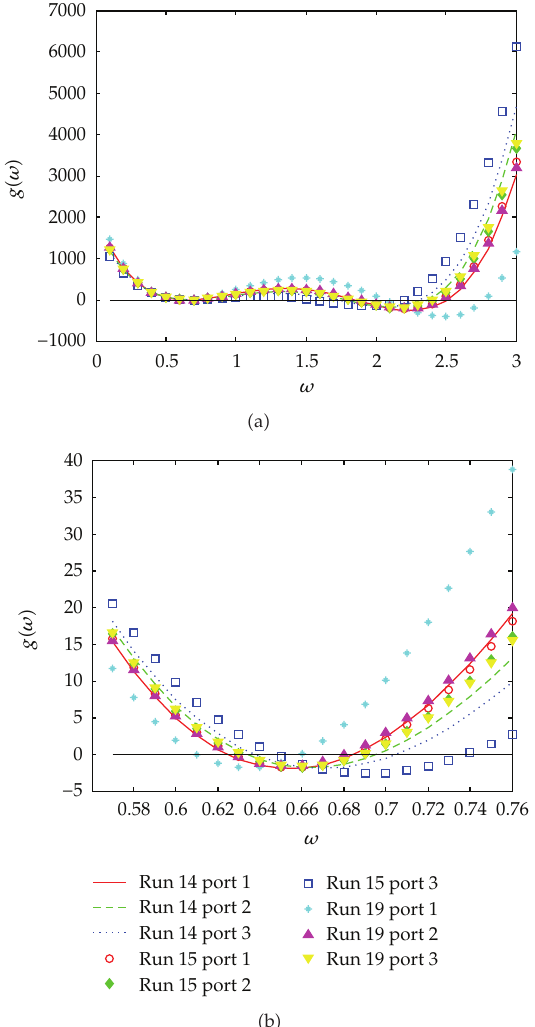
Figure 3: g (cid:2) w (cid:3) for Runs 14, 15, and 19 over (cid:2) a (cid:3) a wide range of ω from 0 to 3 and (cid:2) b (cid:3) a narrow range of ω . the bubbles/drops are assumed spherical in (cid:2) 4.2 (cid:3) . The drag force coe ffi cient for distorted bubbles/drops is employed for field-1 as (cid:4) 22